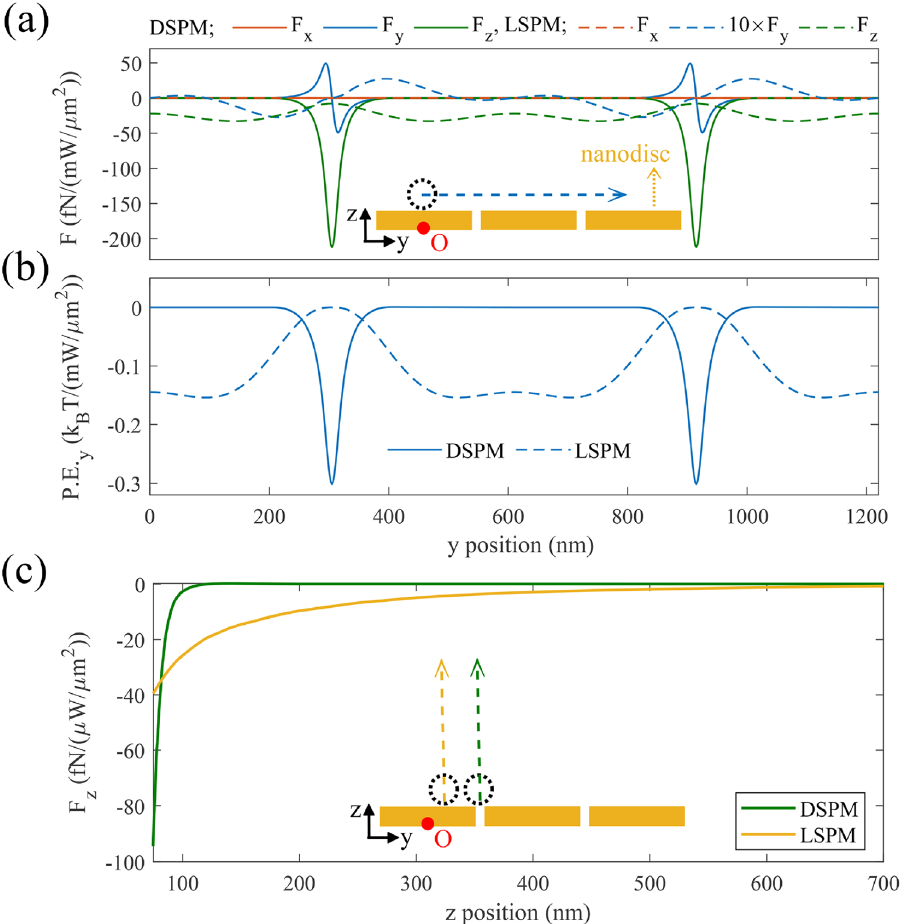
Figure 8. ( a ) The exerted force, and ( b ) the potential energy for a polystyrene particle with r = 25 nm along the y direction (blue dashed arrow) at x = 0, and z = 50 nm relating to the LSPM (dashed curves), and DSPM (solid curves) trapping modes. ( c ) Variations of F z of the LSPM (orange), and DSPM (green) for polystyrene particles at their corresponding trapping equilibrium x – y positions, versus varying z position. The insets show the schematic cross section of the gold discs, and the dashed arrows show the particles moving paths. In the inset of part ( c ) orange and green dashed arrows show the particle movement along the z direction, corresponding to the LSPMs and DSPMs,